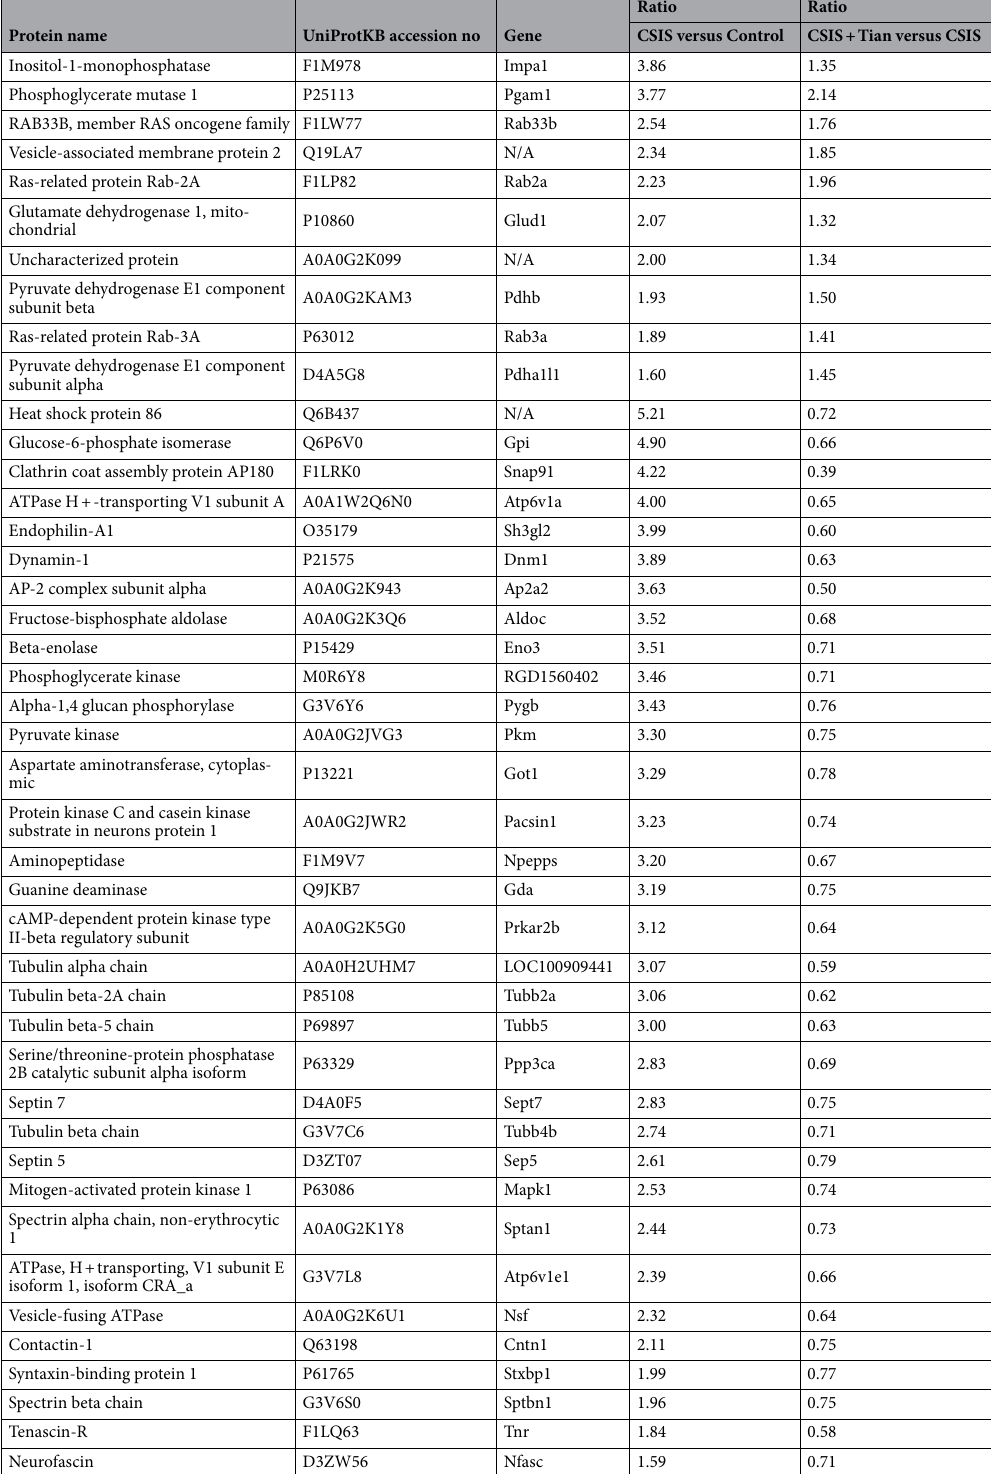
Table 1. The list of differently expressed synaptosomal proteins between CSIS versus Control and CSIS + Tian versus CSIS. CSIS-chronic social isolation, Tian-tianeptine. Proteins were identified according to MS/MS spectra search against the Uniprot/Swissprot database using the Proteome Discoverer (version 1.3) search engine (Thermo Fisher